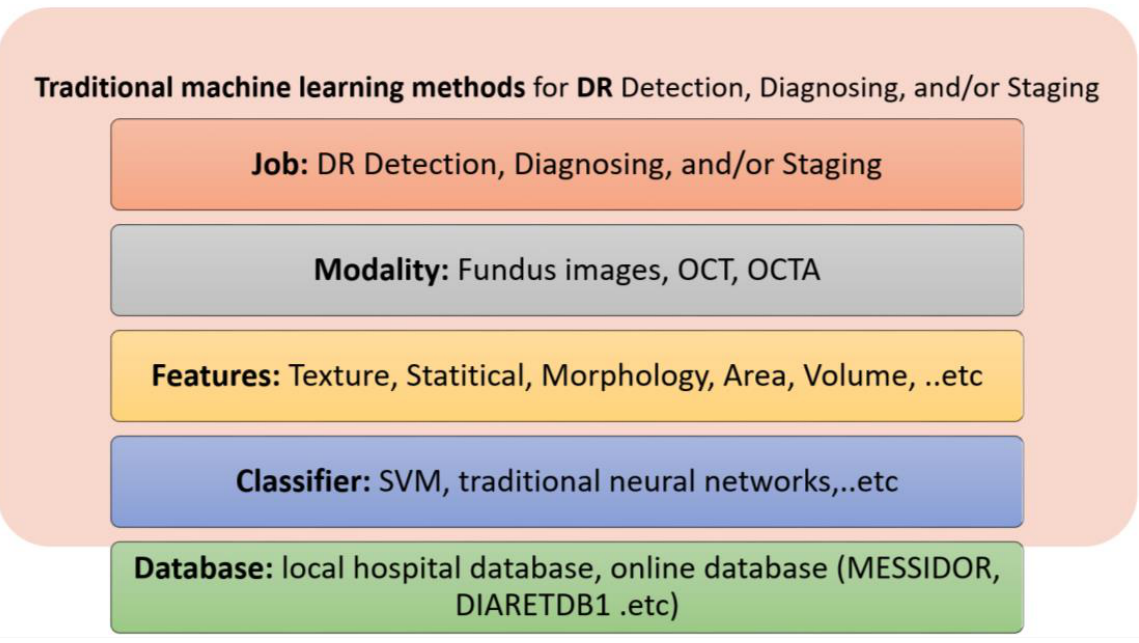
Figure 5. Summary of traditional ML methods for DR detection, diagnosis, and/or staging.